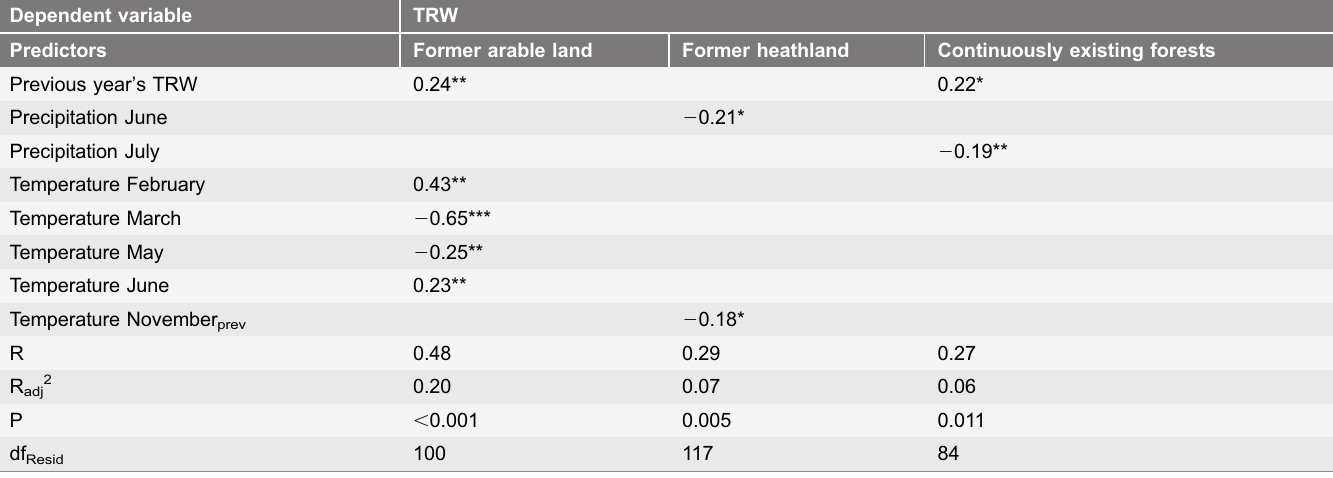
Table 4. Multiple linear regression analyses (stepwise forward selection) of effects of climatic variables on tree-ring width (TRW) of sessile oak trees (n of sample sites 5